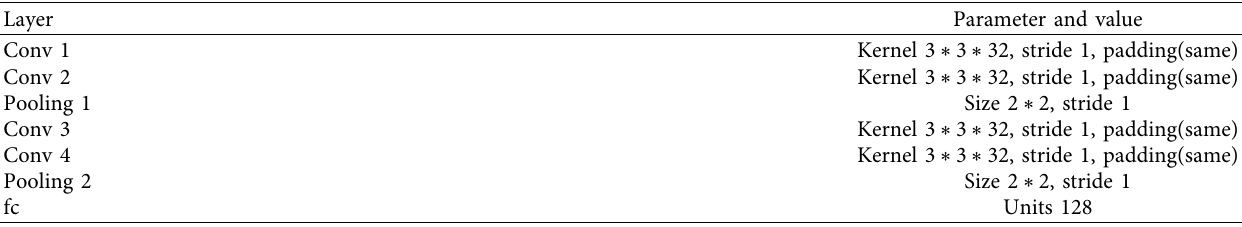
Figure 13: Time-frequency matrix under different health conditions (from left to right, healthy, worn, root cracks, tooth broken, and tooth missing). Table 2: Architecture of VGG-5 network.